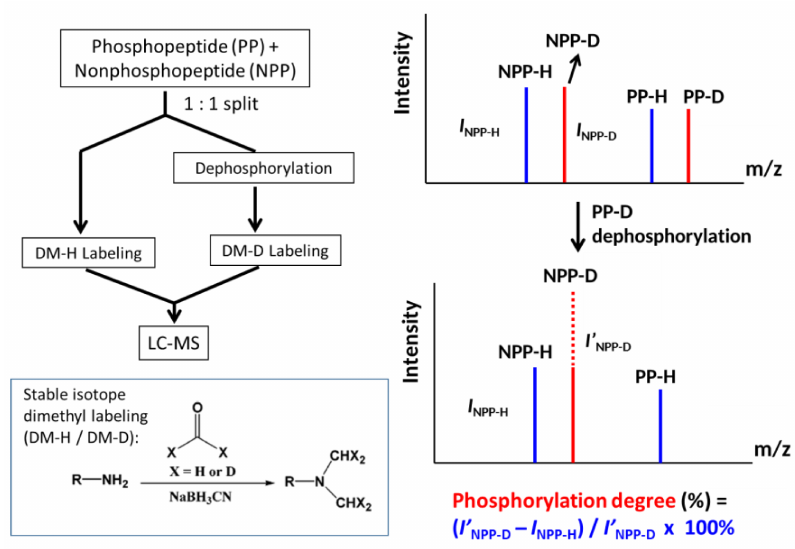
Figure 1. The concept and flowchart of the DM + deP